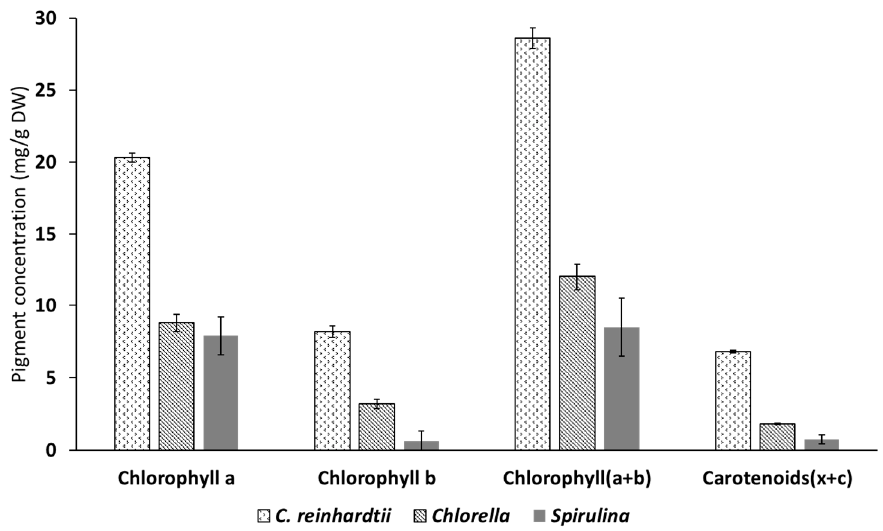
Figure 3. Pigment concentration of Chlamydomonas reinhardti , Spirulina and Chlorella expressed as mg / g DW. Results are the means of triplicate determinations ±